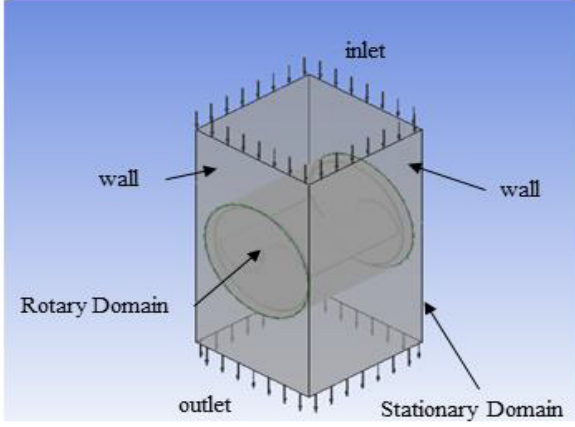
Figure 8: Schematic of CFD simulation.